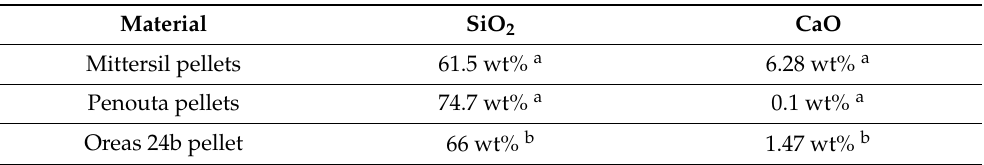
Table 2. Oxide concentration (in weight percent) was used as an internal standard for the ana- lyzed